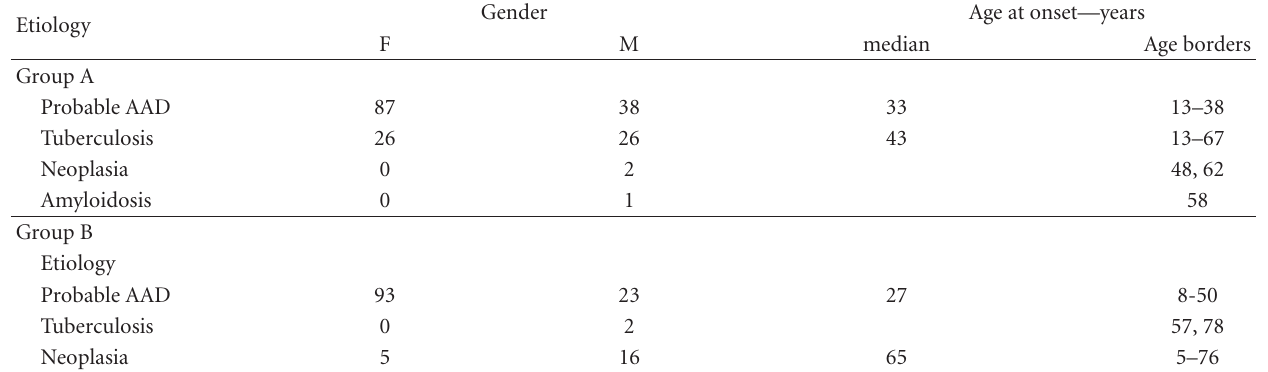
Table 1: Number of patients, gender and age at onset of AD patients in the group A and B.